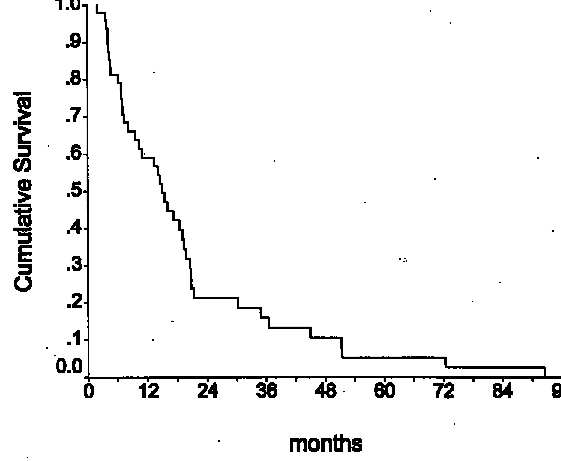
Fig. 1 . Survival by surgery for metastatic disease. Fig. 2 . Overall survival. A Kaplan–Meier curve is presented Kaplan–Meier survival curves are presented with reference to for overall survival in for patients presenting with STS and surgical intervention for STS with synchonous metastases. synchronous metastases ( n = 48; 42 failures; median survival Survival for patients who underwent metastastectomy is repre- 15 months). Overall 2-year survival was 21% sented by the solid line ( n = 31; 26 failures; median survival 1 4 months). Survival for patients who did not undergo metas- tastectomy is represented by the dashed line ( n = 17;16 failures; median survival 16 months).There was no difference in survival ( p = 0.3) .